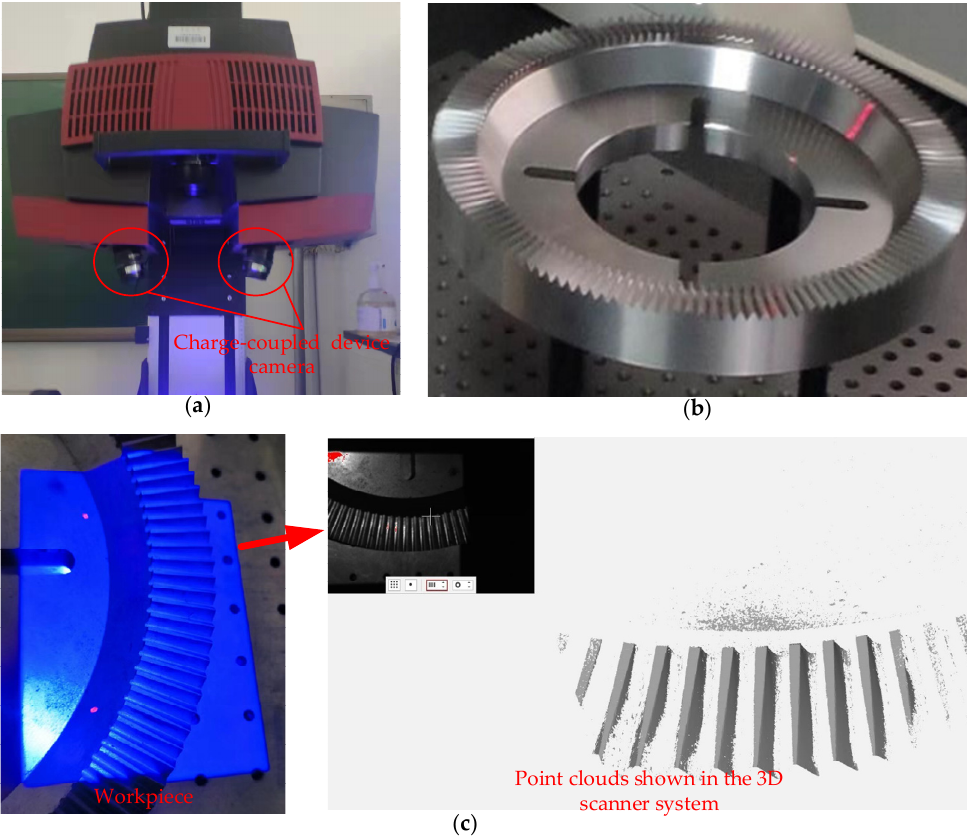
Figure 1. Fringe projection.